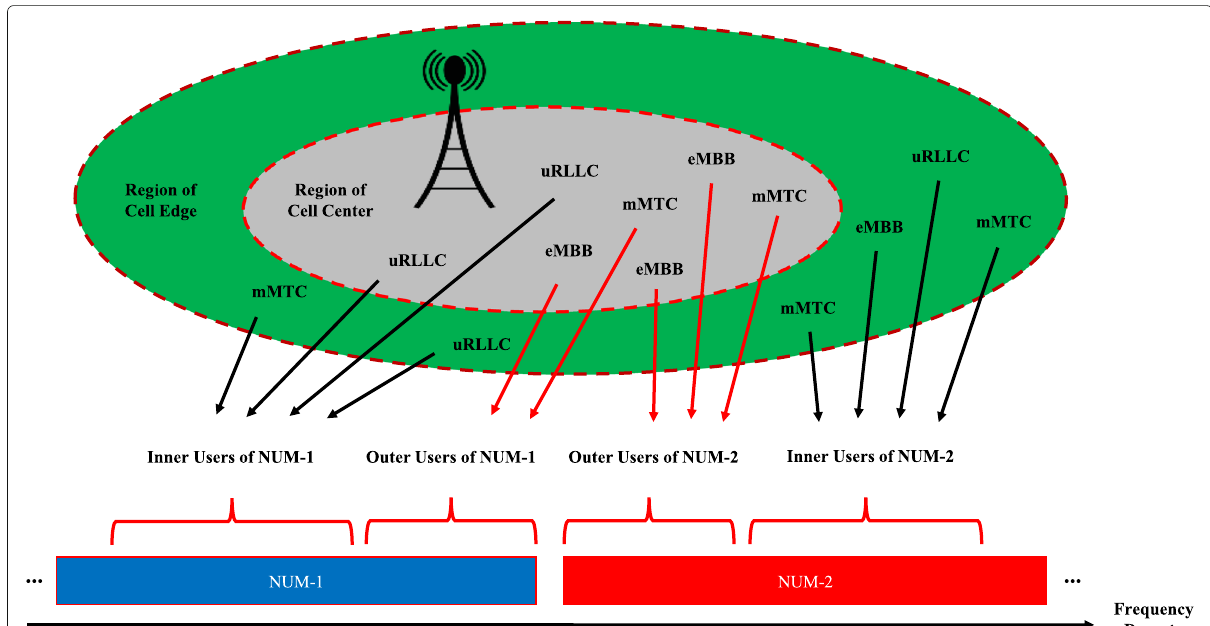
Fig. 3 Protection for uRLLC users and region of cell edge users. It is assumed that there are inter-cell interference in the region of cell edges. Inner regions of the subblocks are safer than the outer regions